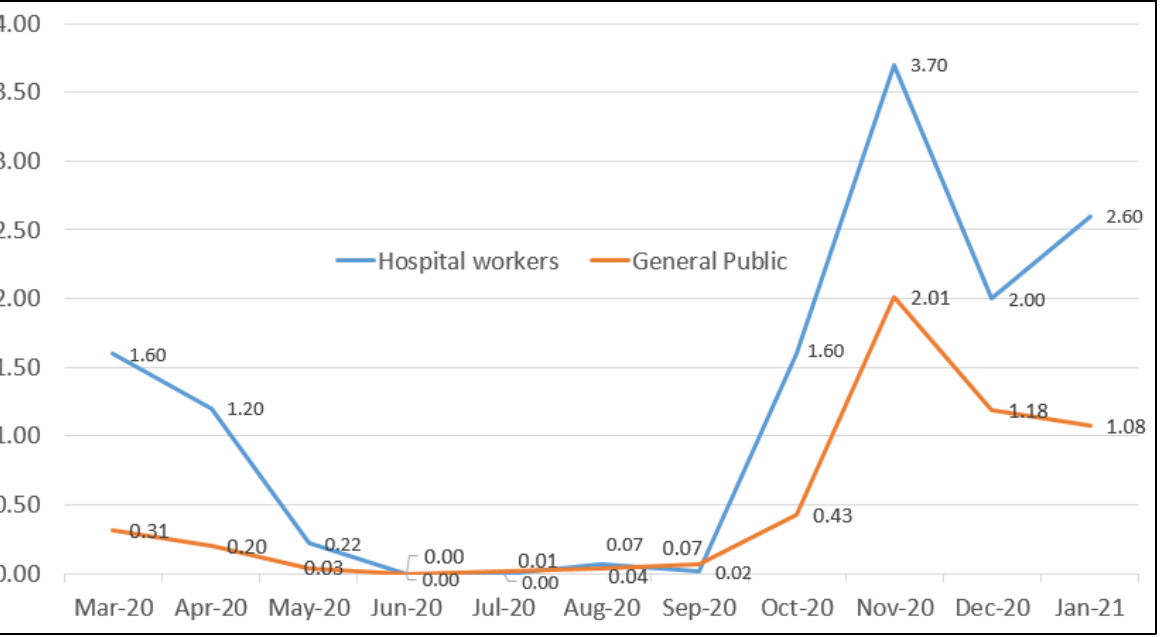
Figure 1. Trends of the SARS-CoV-2 infection rates per 100 subjects per month from March 2020 to January 2021 in the hospital workers vs. the general population of the province of Modena.